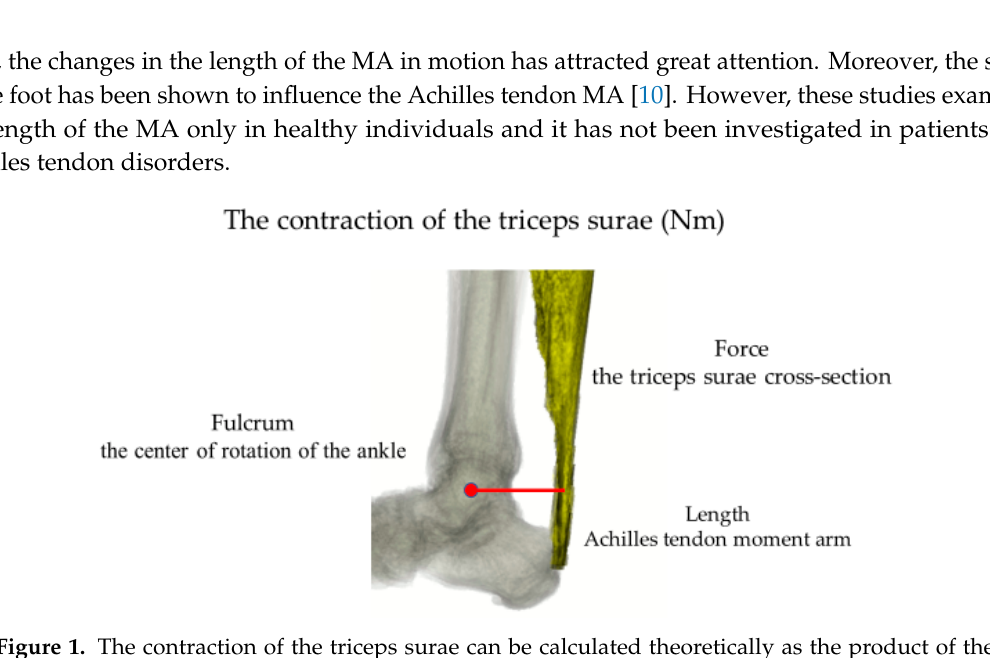
Figure 1. The contraction of the triceps surae can be calculated theoretically as the product of the triceps surae muscle cross-section area and the Achilles tendon moment arm using the lever rule.